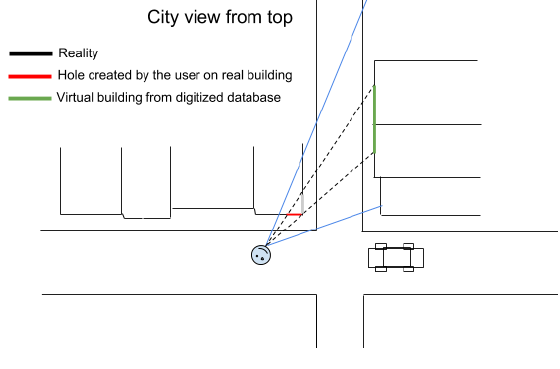
Figure 4. Removing reality elements using background 3D realistic models for